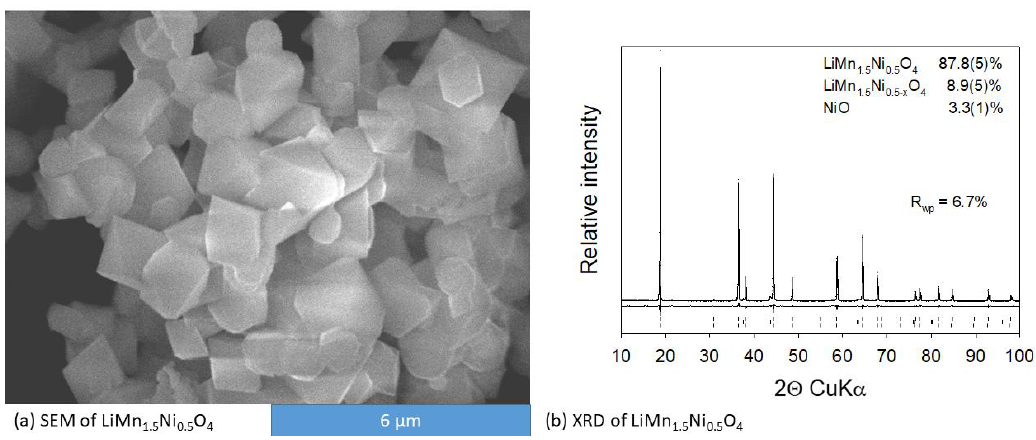
Figure 1. ( a ) SEM image and ( b ) XRD pattern of synthesized LMNO material.